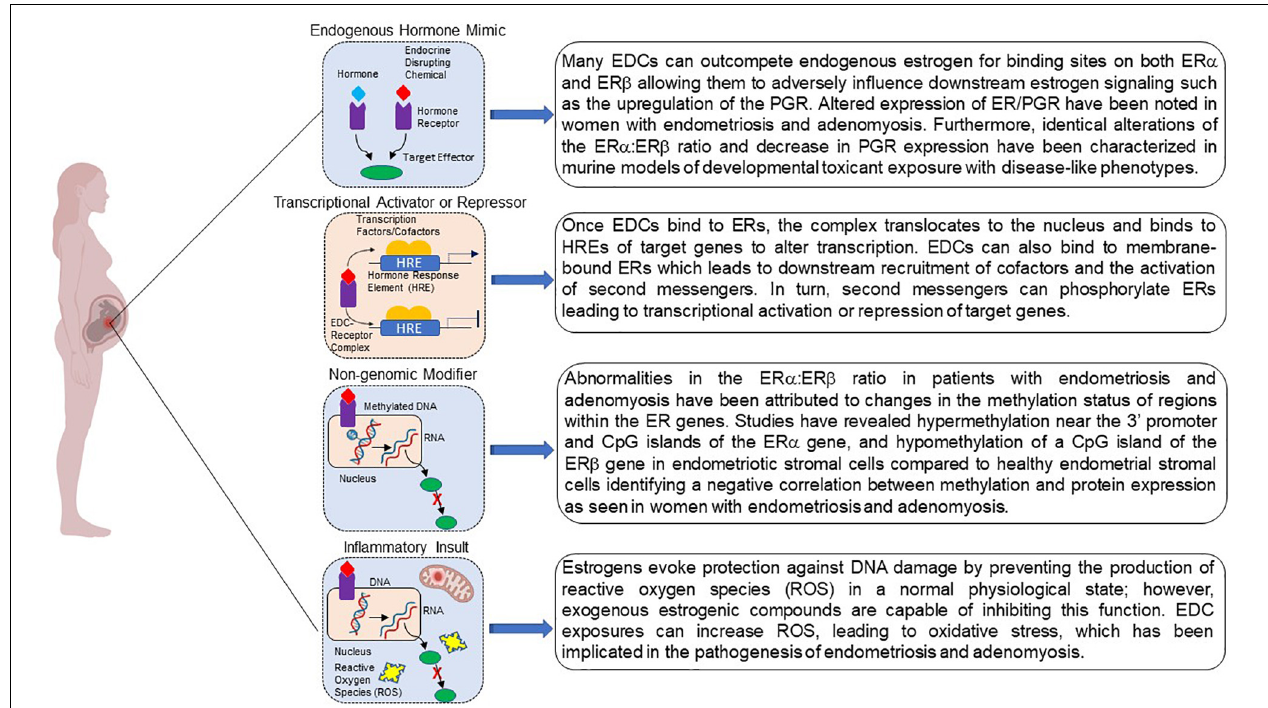
FIGURE 2 | Potential mechanisms by which developmental exposure to environmental endocrine disruptors may induce disease or dysfunction. EDCs may act as steroid agonists or antagonists by binding receptors and interfering with downstream responses. EDCs may also act via non-genomic mechanisms via binding to G-protein coupled receptors. Finally, interference with steroid action can promote inflammation via a variety of mechanisms, including the failure to curtail production of reactive oxygen species. Created with BioRender.com.